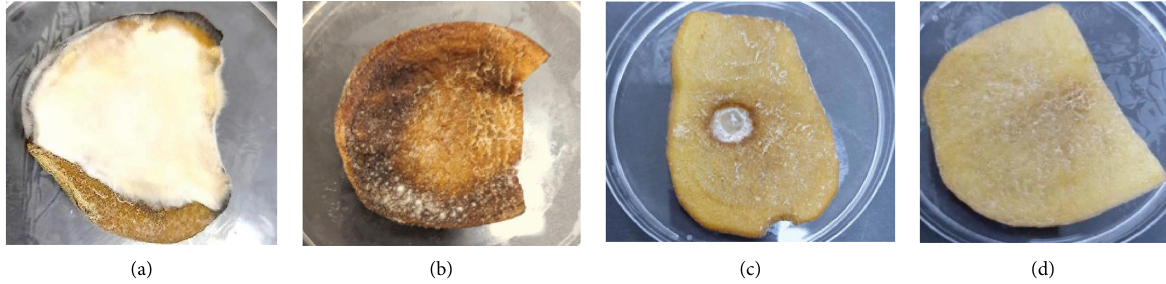
Figure 1: R. Solani’s reaction to Paecilomyces fltrate on potato slices, (a) R. solani -inoculated potato slices, (b) solely with PDB medium, (c) with Paecilomyces fltrate and R. solani , (d) treated with Paecilomyces fltrate alone, and. Growth was tested at 28 ° C for 7days.